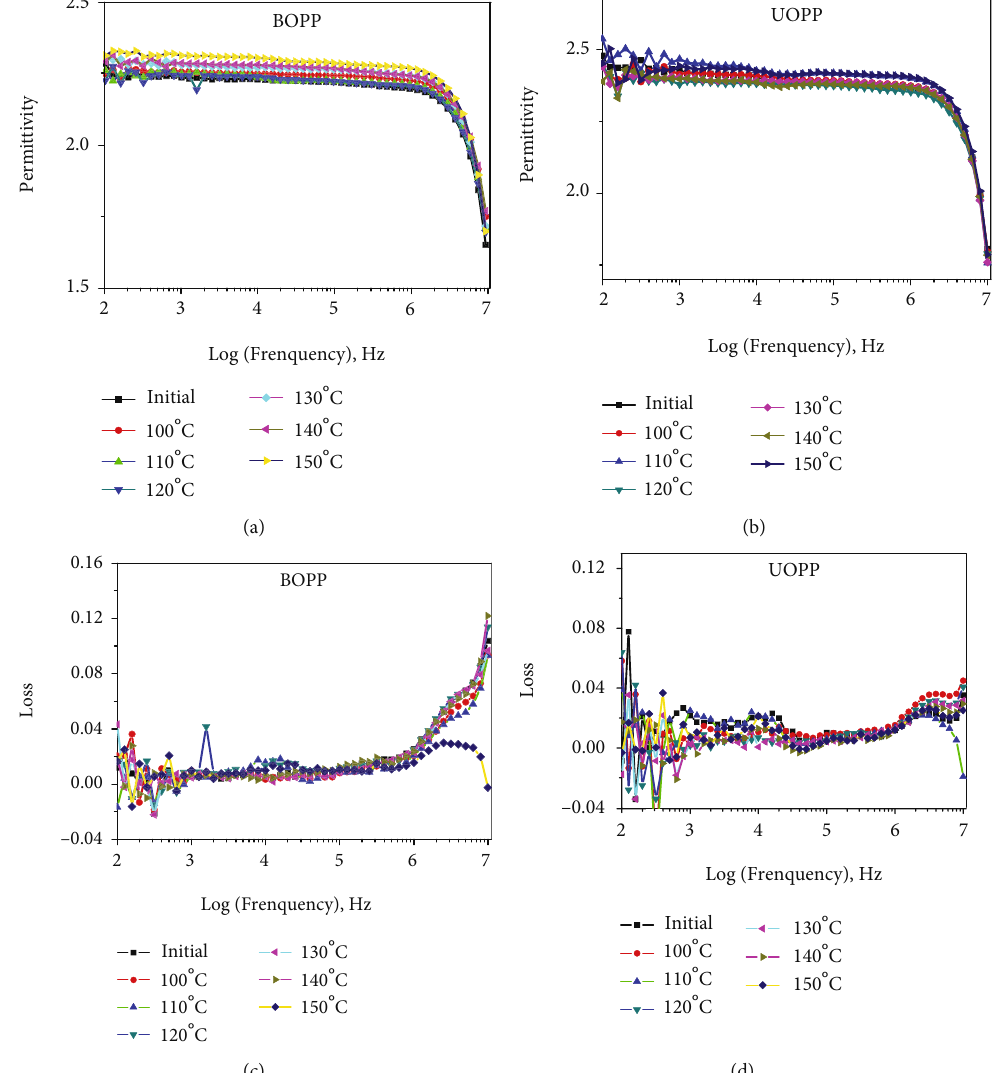
Figure 1: Permittivity and dielectric loss of the PP fi lms. Permittivity of (a) BOPP and (b) UOPP. Dielectric loss of (c) BOPP and (d)